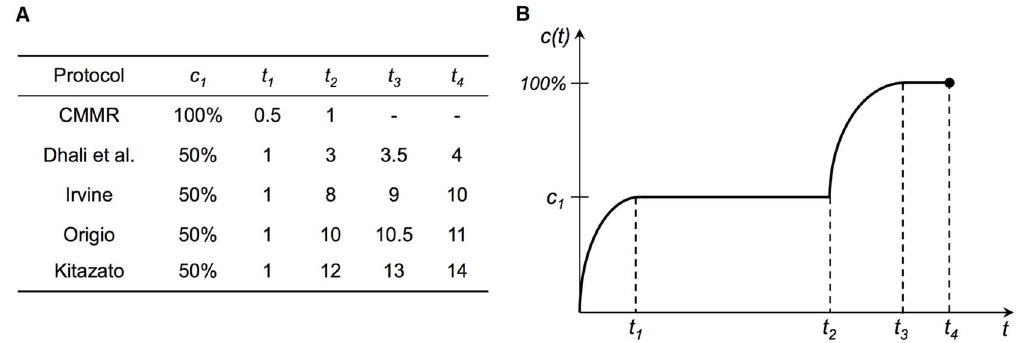
Figure 7. Vitrification protocol implementation on digital microfluidic chip. Implementation of common vitrification protocols on a digital microfluidic chip with a single dispensing reservoir. Timings and concentrations are shown in (A), and the generalized mixing curve is shown in (B).